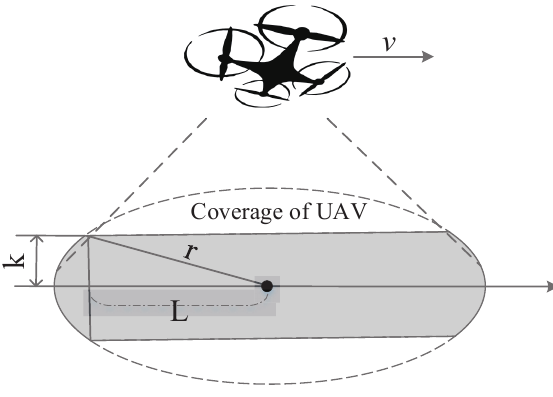
Figure 2. Coverage analysis of UAV-based aerial base